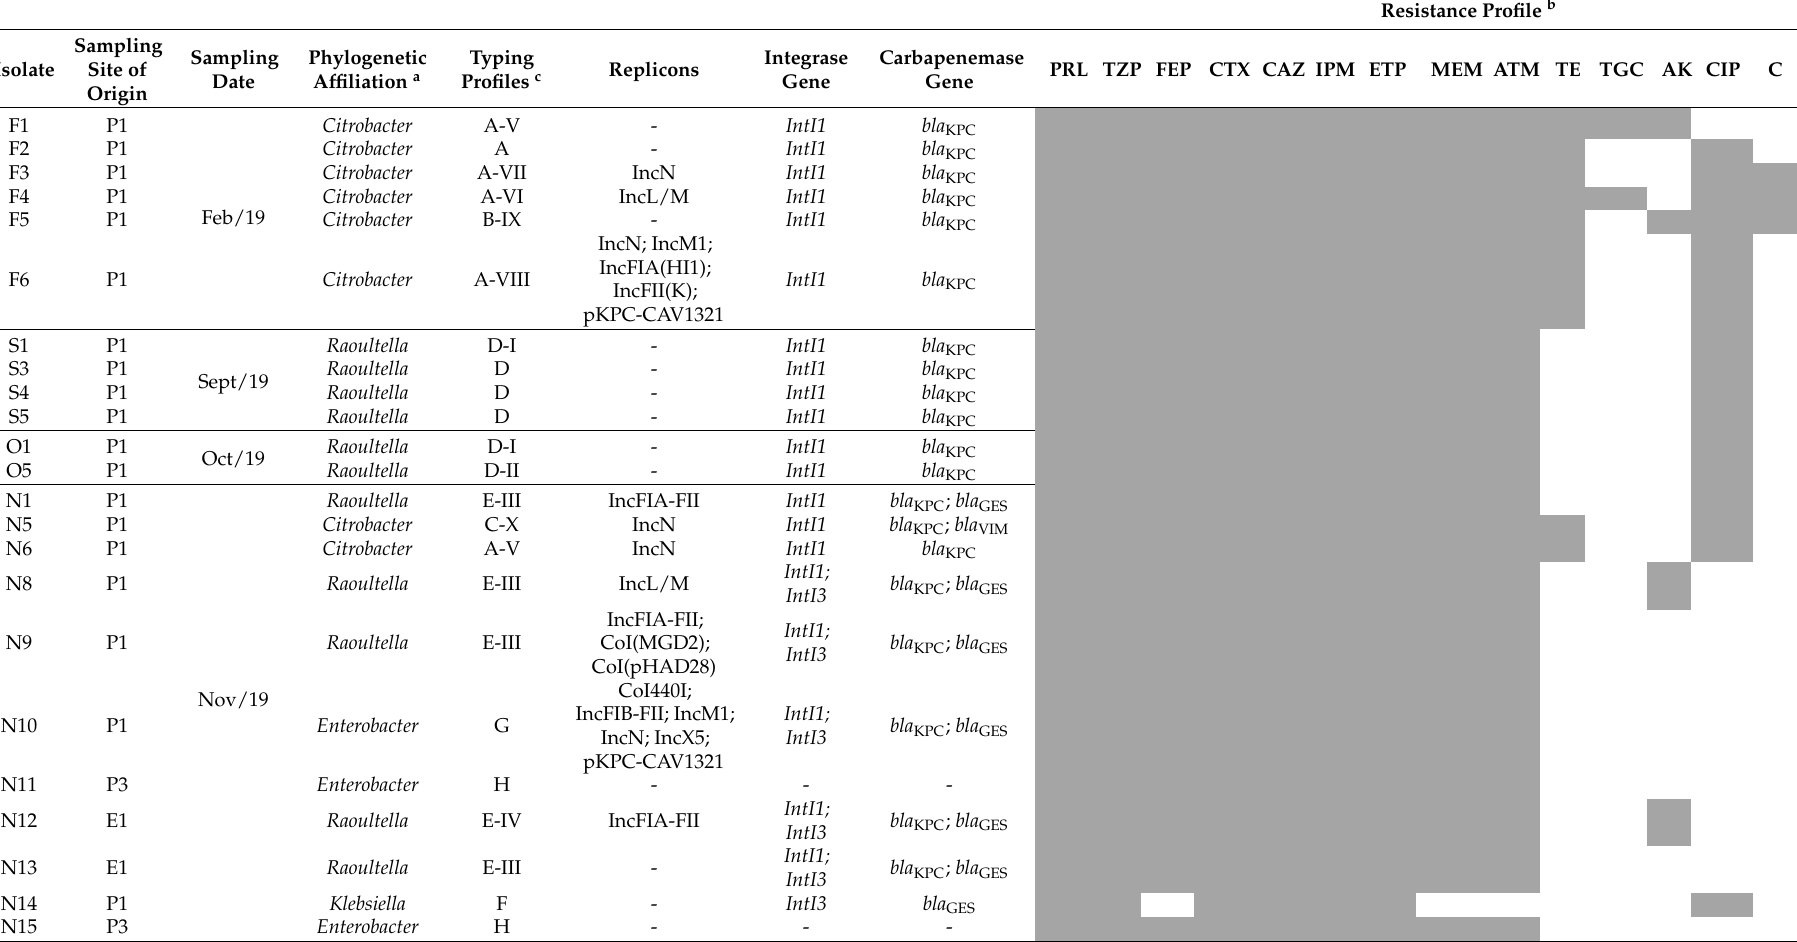
Resistance Profile